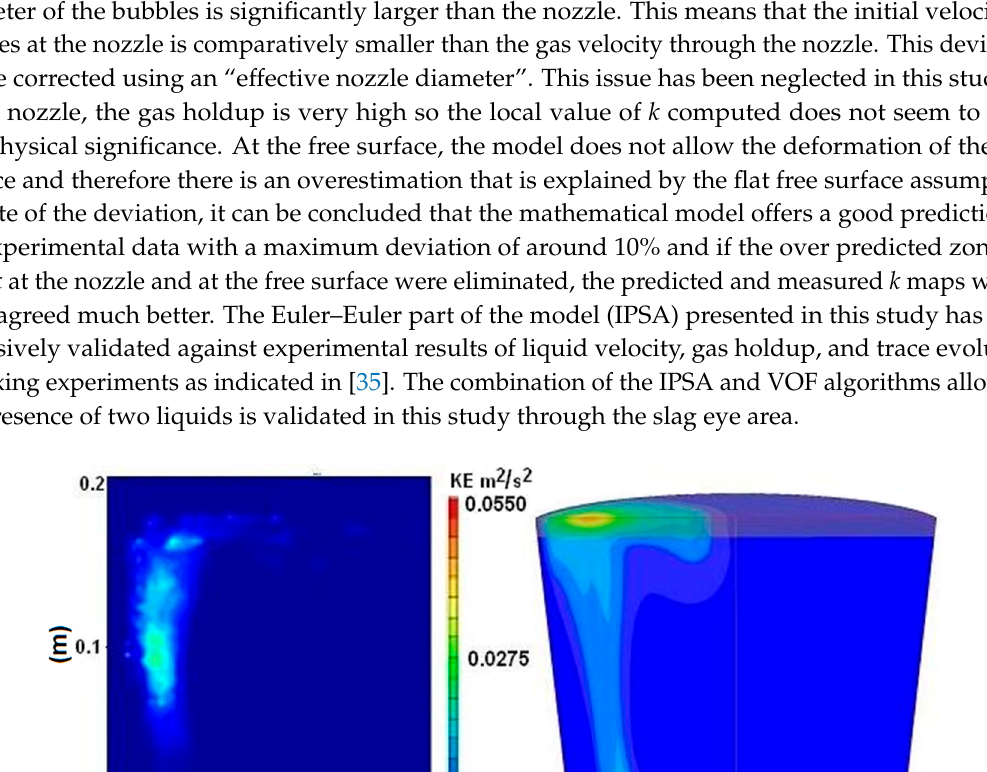
Table 3. Geometrical and physical variables needed for the simulations.